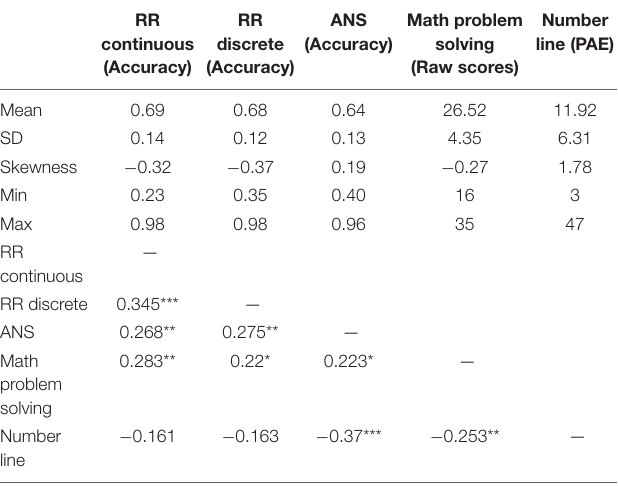
TABLE 2 | Descriptive statistics and zero-order